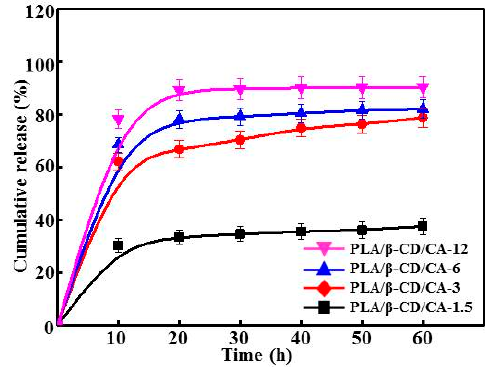
Figure 4. Antibacterial activity. The cumulative release profiles of CA from different fibers; n = 6.